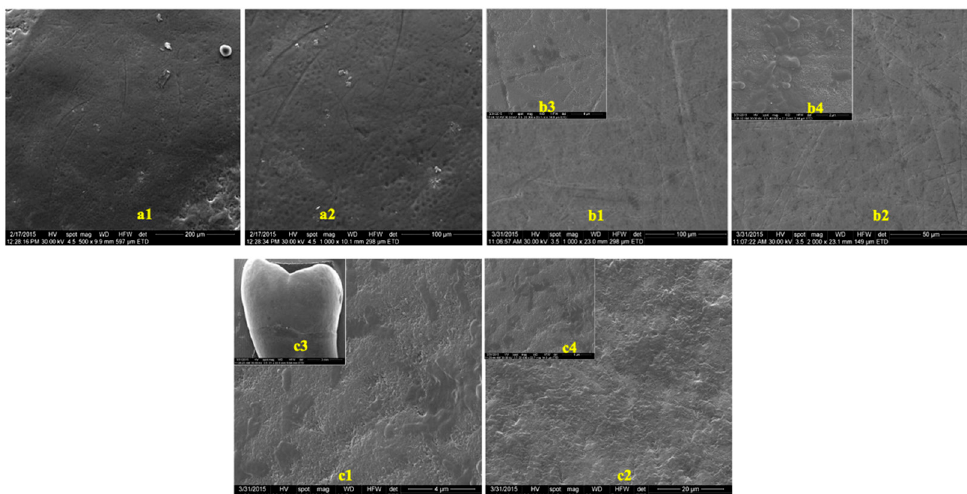
Figure 3. SEM images of enamel samples from predialysis patients: ( a ) before bleaching; ( b ) after 16% whitening; ( c ) after 40% whitening. ( a1 ) Magnification—500×; ( a2 ) magnification—1000×; ( b1 , c1 ) magnification—1000×; ( b2 , c2 ) magnification—2000×; ( b3 ) magnification—40,000×; ( b4 , c4 ) magnification—20,000×; c3: magnification—5000×.